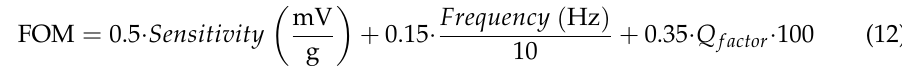
Table 2. Geometric and performance of initial and final accelerometer.